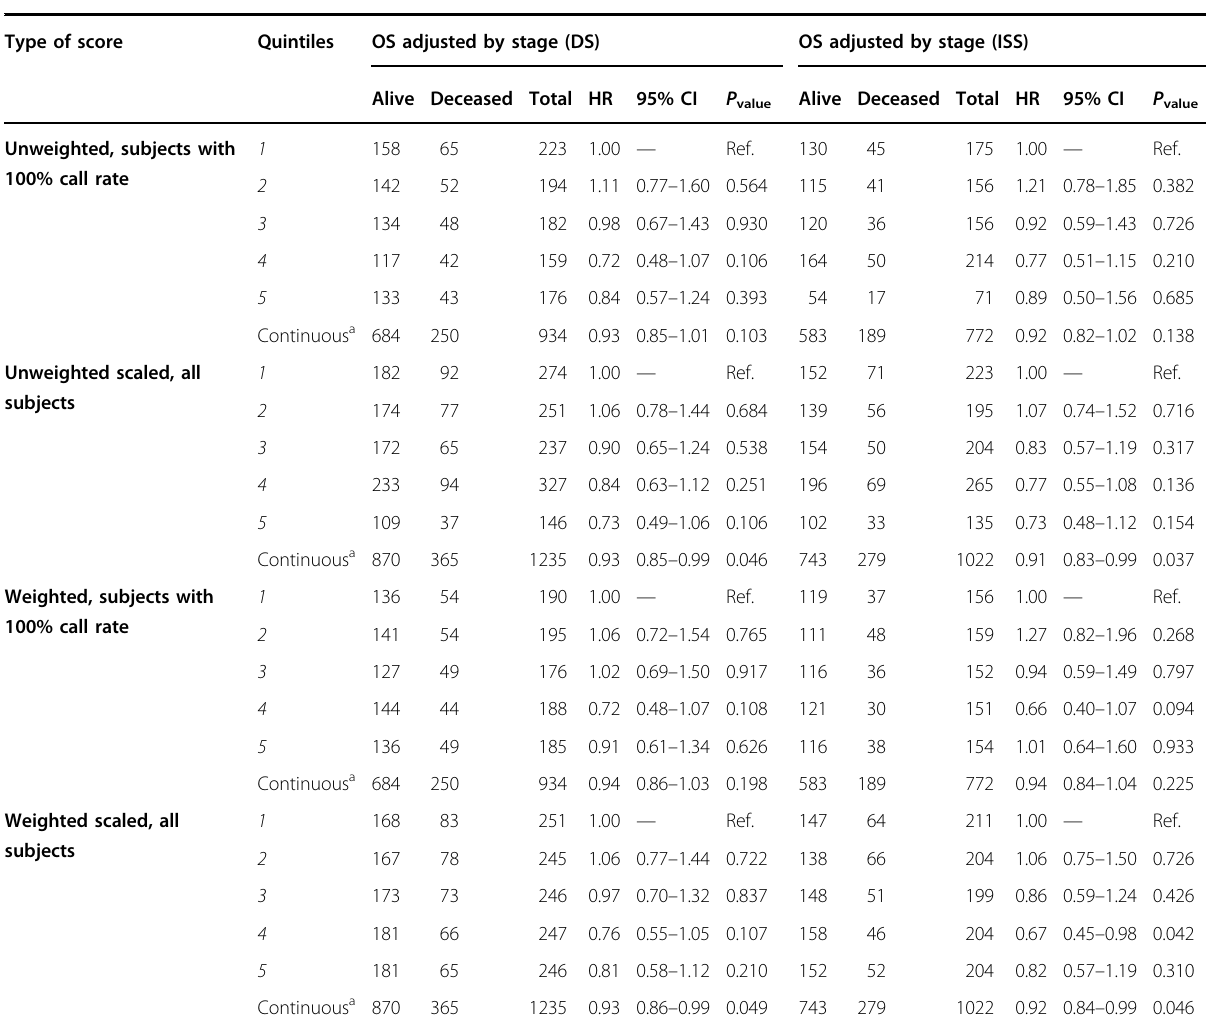
Table 5 Association between teloscore and MM OS. Type of score Quintiles